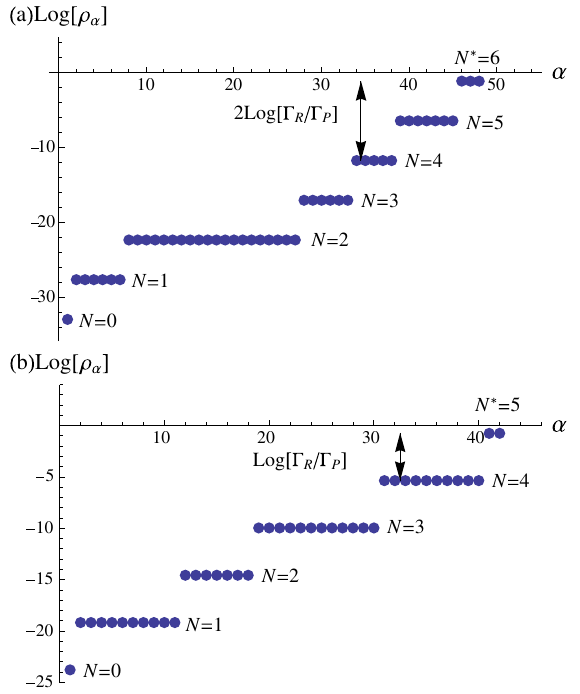
FIG. 5. Long-time stabilization of (a) Moore-Read and (b) Laughlin states. (a) Using the refilling rate approximation [Eqs. (7) and (8)], we study the dynamics of a 6 × 4 lattice with periodic boundary conditions, ϕ ¼ 1 = 4 , and a hard-core three- body interaction. In this limit, the exact ground state at N ¼ N (cid:2) ¼ 6 is a Moore-Read state [49], which is threefold degenerate on the torus. In the figure, we plot the logarithm of the ordered eigenvalues ρ α describing the equilibrium occupation of the lowest 200 Γ Landau level states (other states not shown) for Γ and R ¼ P Γ ≪ Δ . Each level corresponds to a fixed particle number N , with R N ¼ 6 being the Moore-Read state. The equilibrium occupations (probability of finding the system in that state when a measurement is made) of the LLL states can be modeled by an induced chemical ≃ log ð Γ =T = Γ potential and temperature μ . The final R P Þ ind ind occupation of the three Moore-Read states is 99% in this case. In such a small system, equilibration was rapid, but as remarked in the text, the exponential suppression of fractionalization in large systems leaves the equilibration rate an open question. (b) Long- time configuration of a 5 × 5 lattice with N ϕ ¼ 10 and hard-core 100 Γ two-body interactions, with Γ . The occupation of the R ¼ P two Laughlin states at N ¼ N (cid:2) ¼ 5 is